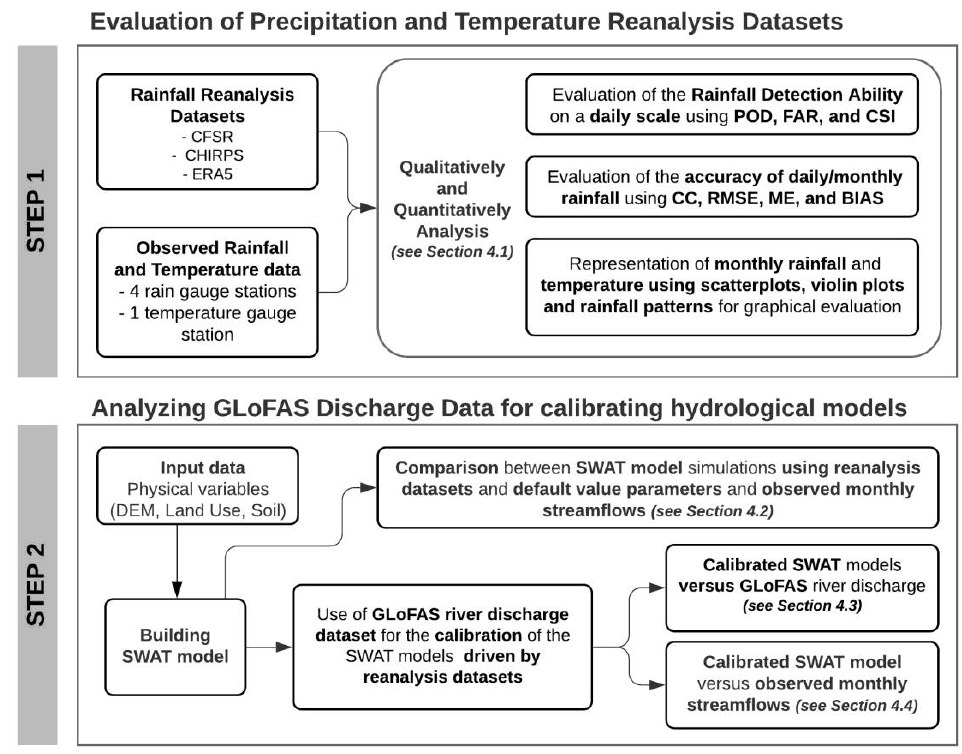
Figure 2. Flowchart of the methodological approach used in this study.